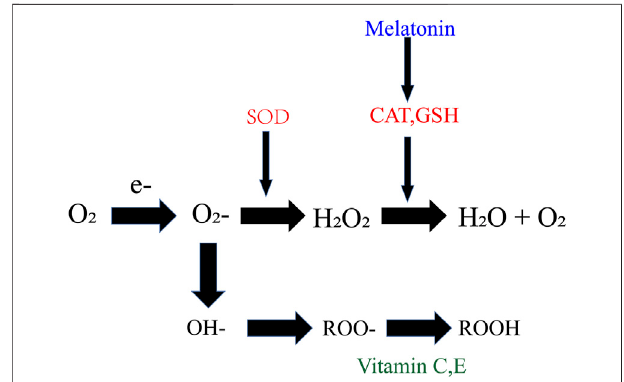
Frontiers in Genetics |